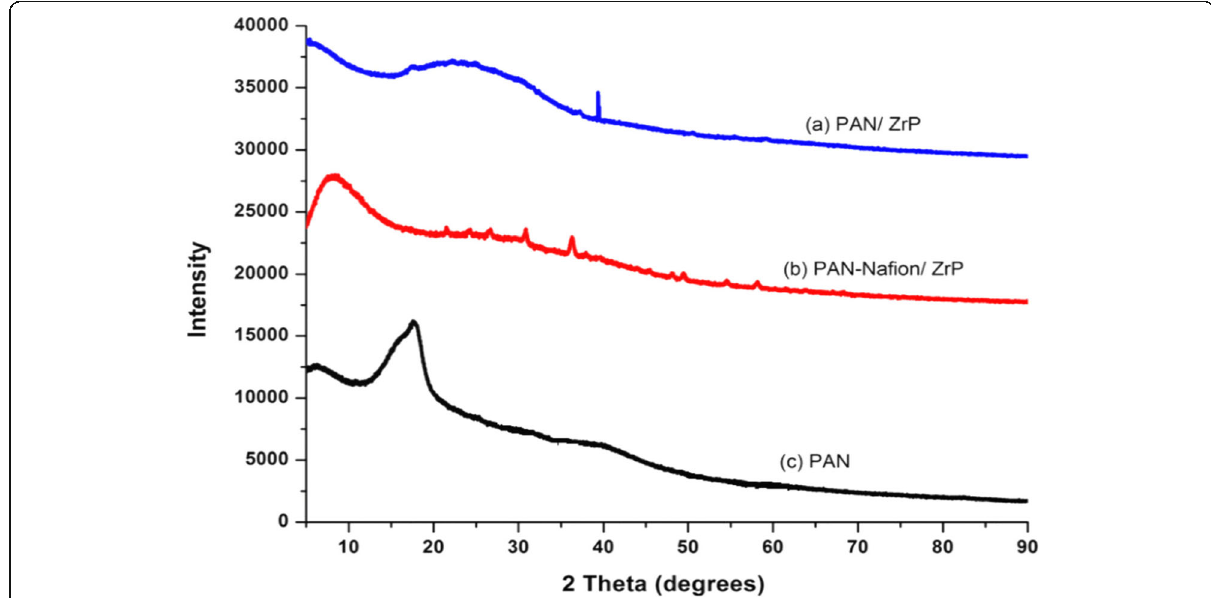
Fig. 4 The comparison of the XRD patterns of the a PAN/ZrP nanofibres, b PAN-Nafion ® /ZrP nanofibres and c PAN